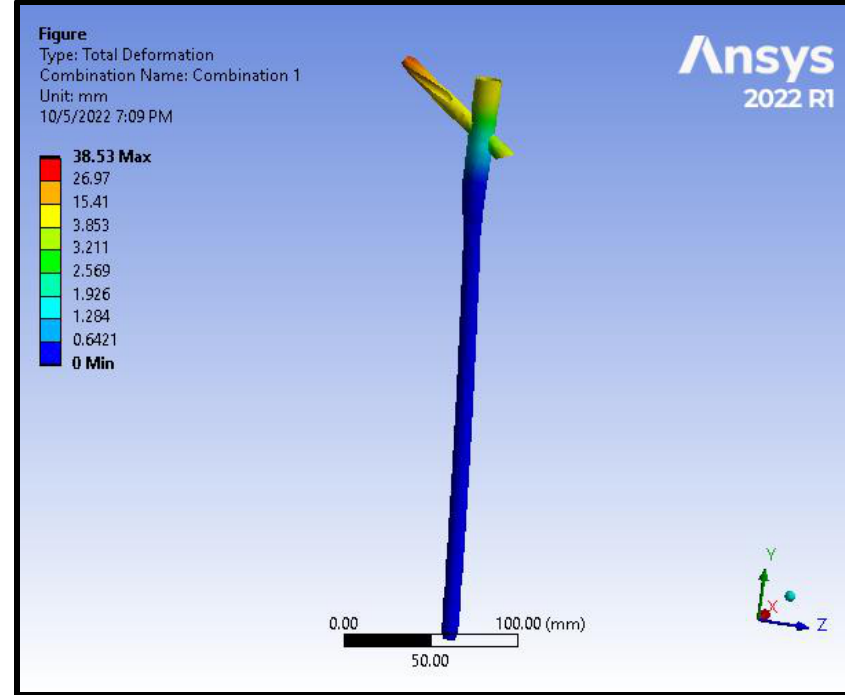
Figure 11. Total deformation distribution on the nail and the helical screw from the model of an intracapsular fracture under axial compression and torsion scenario.